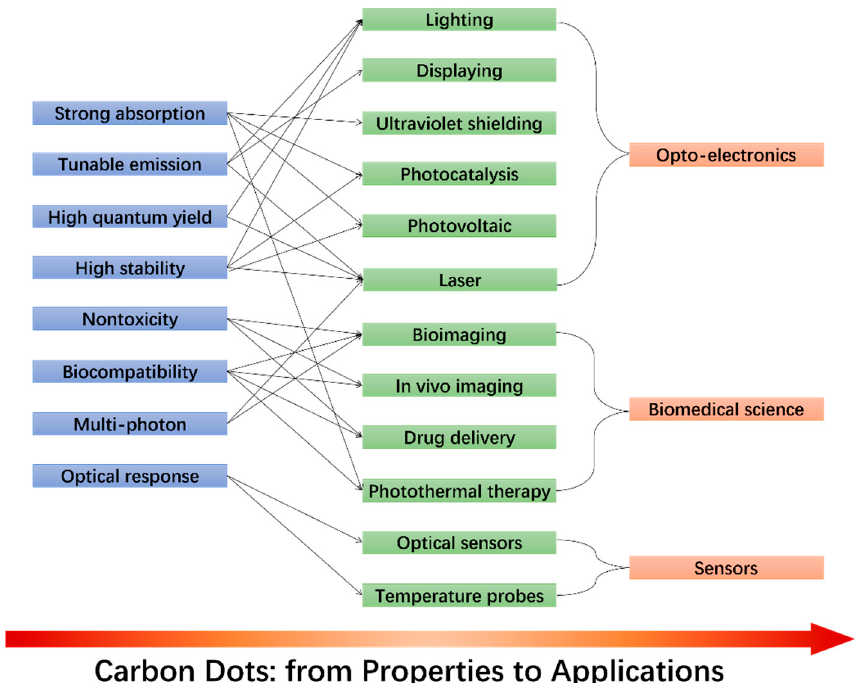
Figure 10. CDs’ optical properties and potential applications.